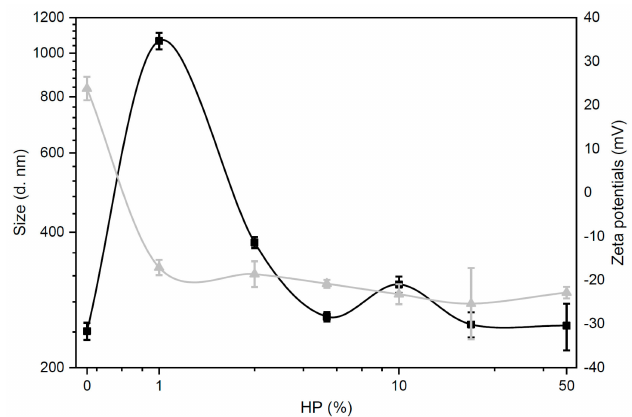
Figure 2. Size (black squares) and zeta-potential (grey triangles) of biocoronated grapholipoplexes as a function of human plasma (HP)